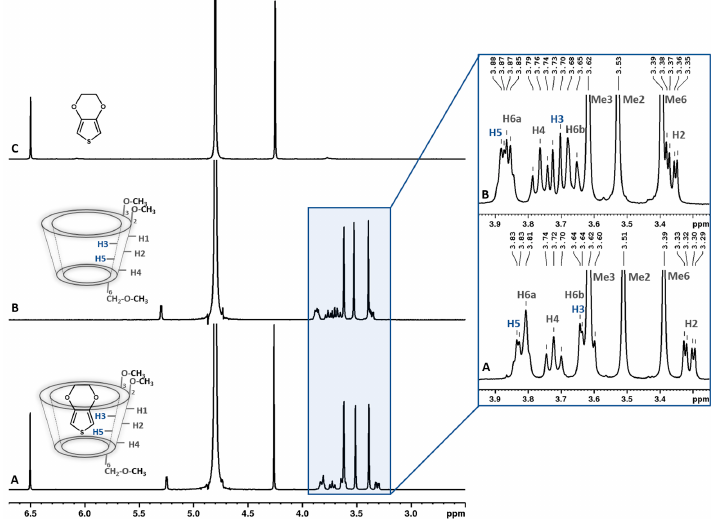
Figure 3. 1 H-NMR (400 MHz, D 2 O) spectra for: EDOT ∙ TMe- β CD ( A ); TMe- β CD ( B ); and EDOT ( C ). The inset shows detail of the 3.95–3.25 ppm region of the spectra.